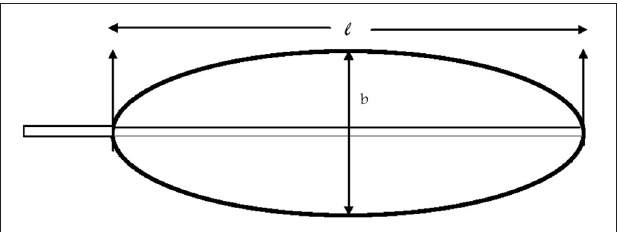
FIGURE 2 | Diagram representing the banana leaf for measuring lamina length ( l ) and width ( b